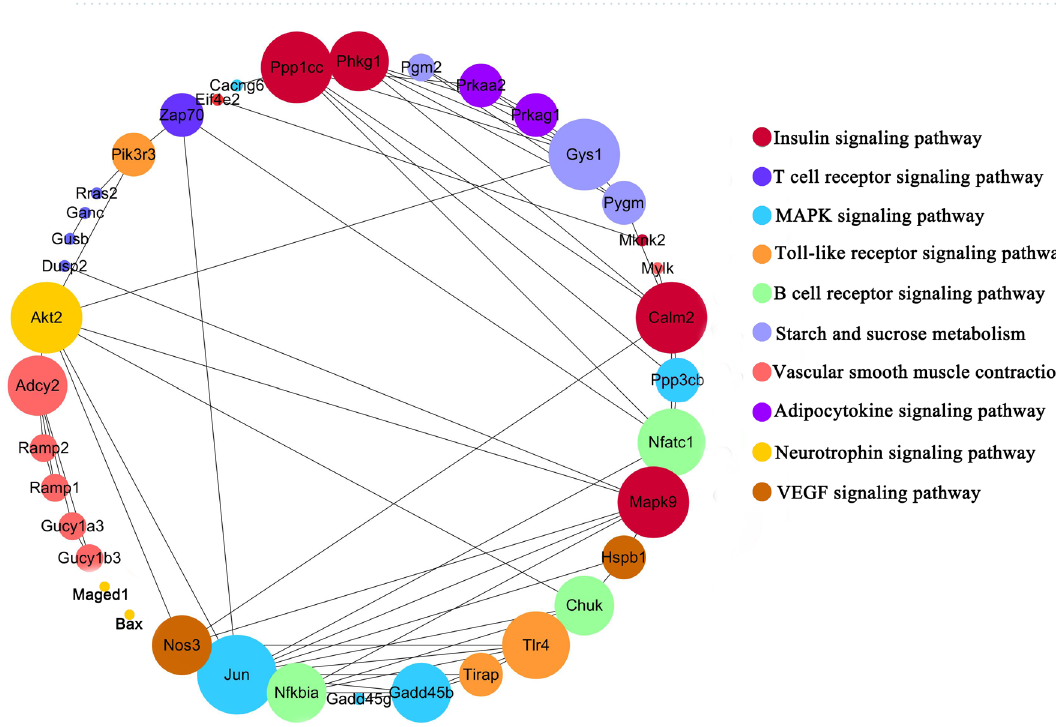
Figure 6. KEGG analysis of den-genes. Lines highlight KEGG network, with Jun, Mapk9, Calm2, Gys1, Ppp1cc, and Akt2 presenting the highest degree of interactions. Colors highlight KEGG pathways of the circle network components. The larger the circle, the higher the interaction degree identified. Cytoscape v. 3.7.2 was used to generate the resulting network. Permission has been obtained from Kanehisa laboratories for using KEGG pathway database 33